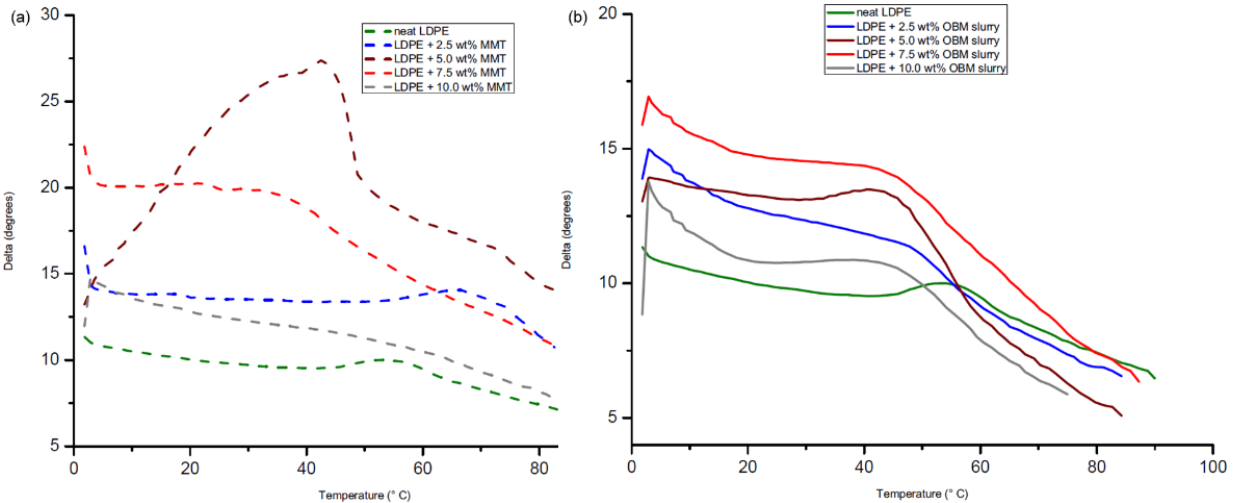
Figure 18. Influence of applied shear stress on damping property of ( a ) neat LDPE and LDPE/MMT and ( b ) neat LDPE and LDPE/OBM slurry nanocomposites.